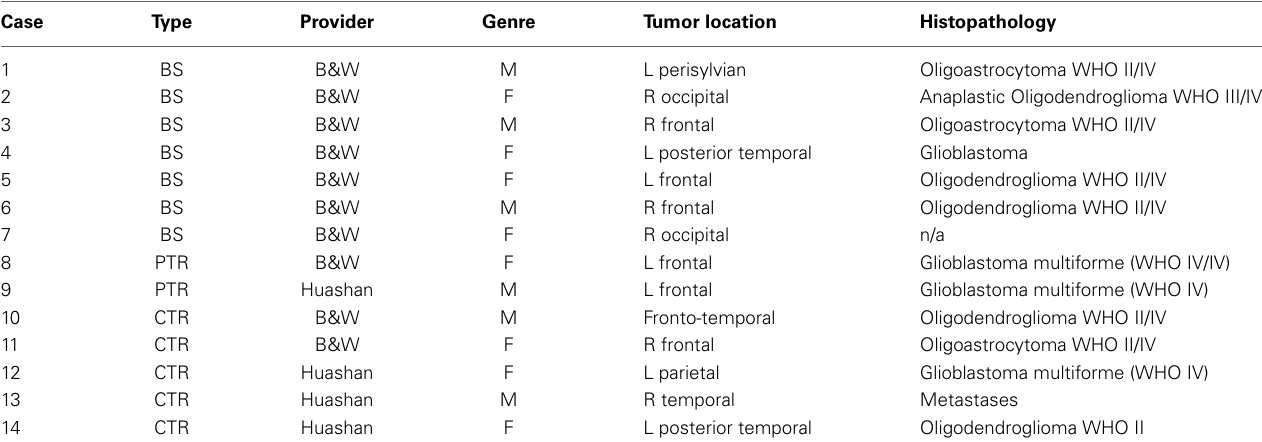
Table 2 | The clinical MRI data of this study.